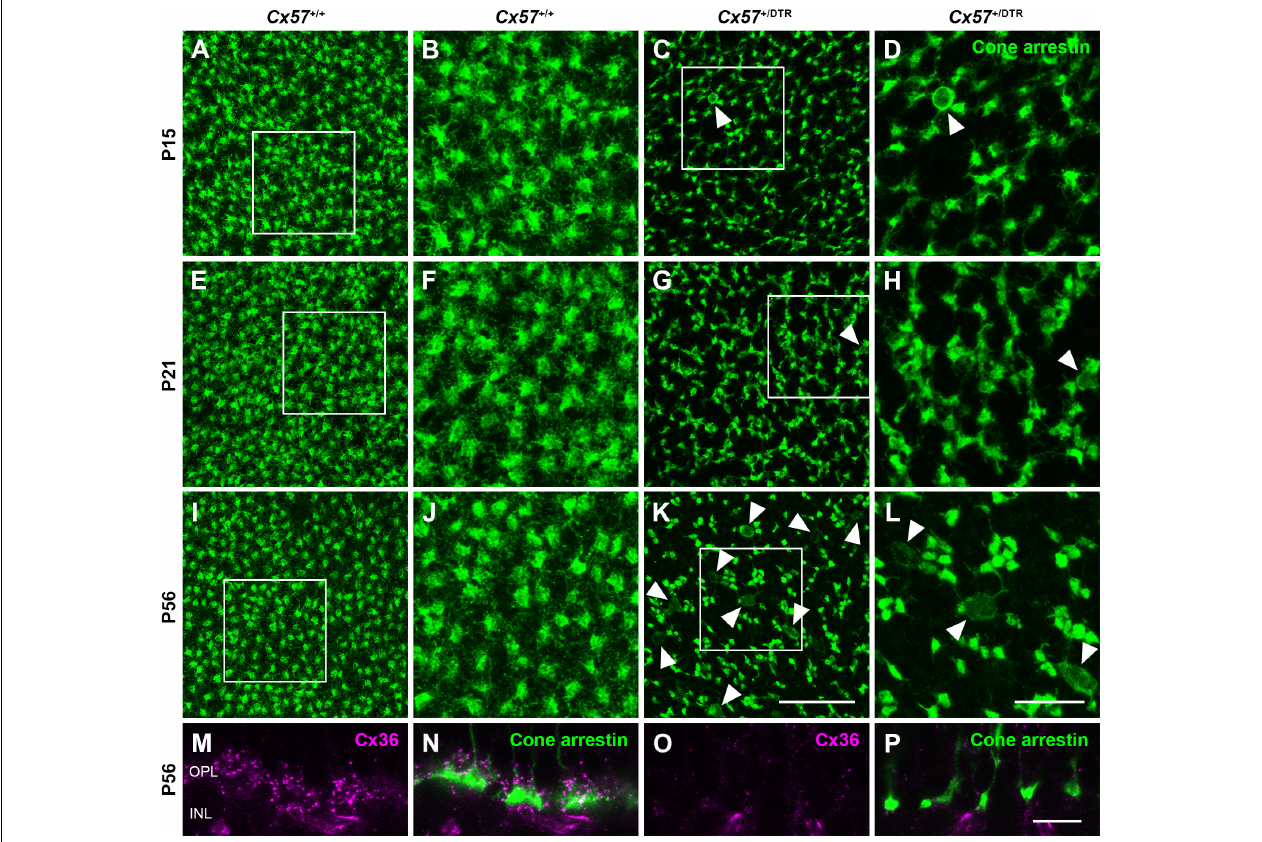
FIGURE 4 | Clustering and reduced gap junctional coupling of cone terminals in horizontal cell-ablated mice. (A–L) Immunolabeling of retinal whole mounts from Cx57 + / + and Cx57 + / DTR mice with antibodies against cone arrestin. In the OPL of wild-type mice, cone pedicles formed a regular mosaic (A,B,E,F,I,J) , whereas in horizontal cell-ablated mice, cone pedicles were unevenly spaced and several mislocalized cone somata were apparent (arrowheads) (C,D,G,H,K,L) . (M–P) Vertical sections of Cx57 + / + and Cx57 + / DTR retinae were stained for cone arrestin (green) and Cx36 (magenta). Cx36 expression in the OPL of horizontal cell-ablated mice was strongly reduced compared to wild-type mice. Scale bars, 25 µ m (K) , 10 µ m (L,P)